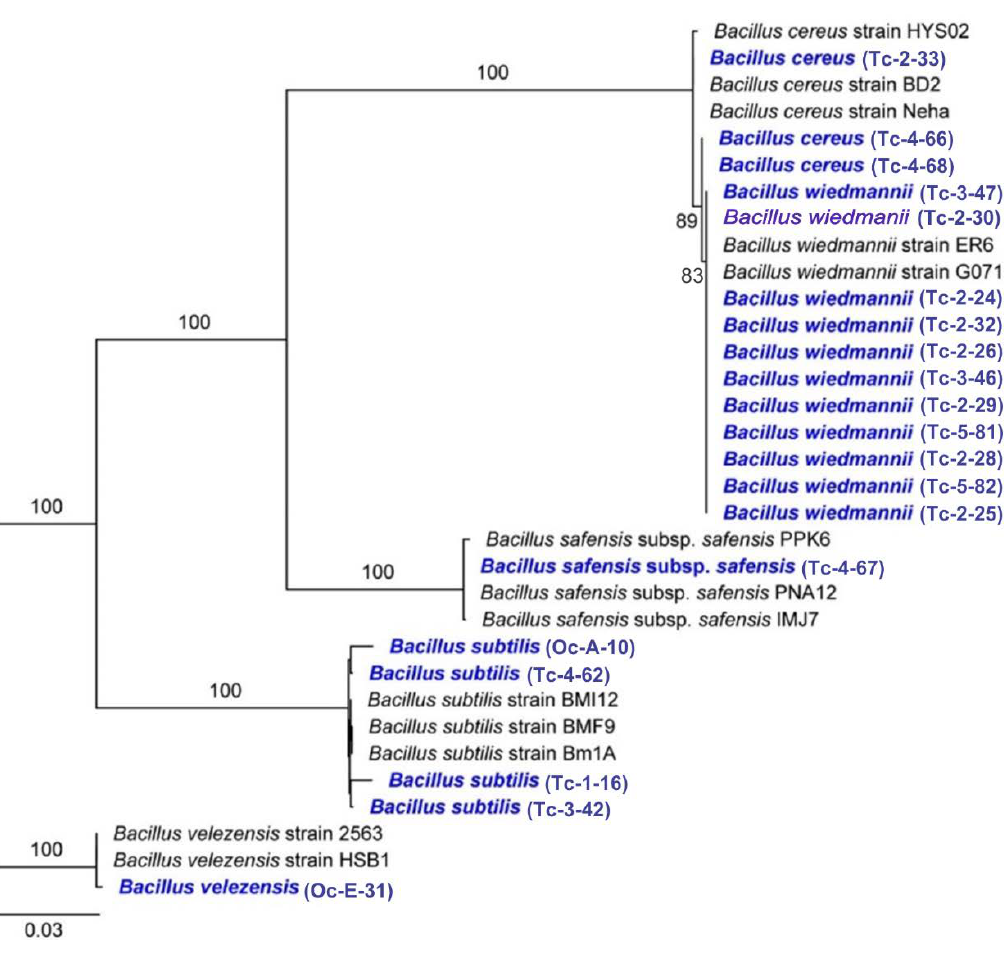
Figure 2. Maximum likelihood phylogram of bacterial isolates from CMCP and OPF based on three markers. Numbers along branches are RaxML bootstrap supports based on 1000 replicates. The legend below represents the scale for nucleotide substitutions.